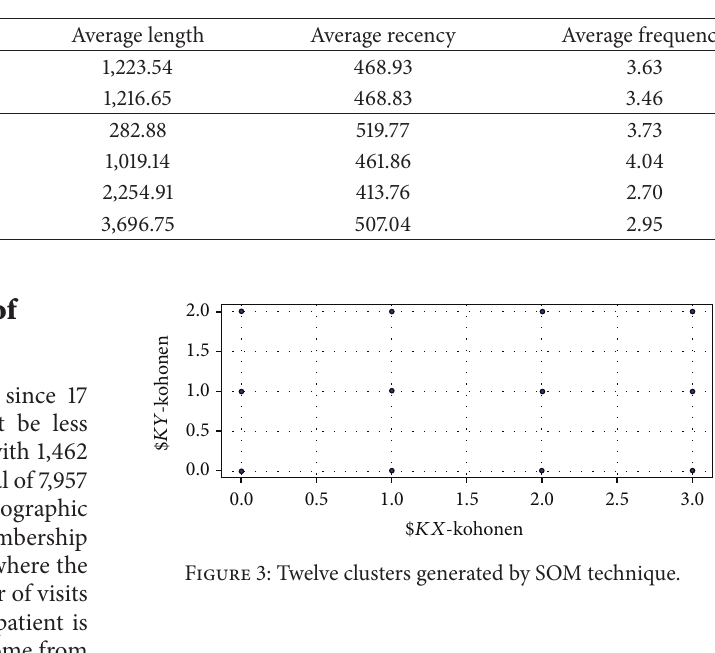
Table 3: The characteristics of length, recency, and frequency for different genders and age groups.